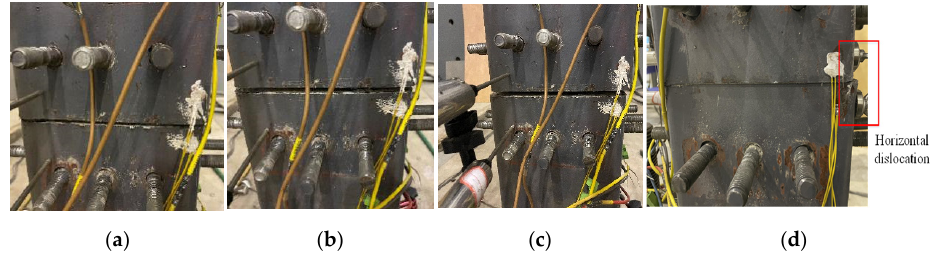
Figure 11. Tension at the joints, ( a ) Offset rate 2.2%, ( b ) Offset rate 3.2%, ( c ) Offset rate 4.2%, ( d ) Horizontal dislocation at seam.